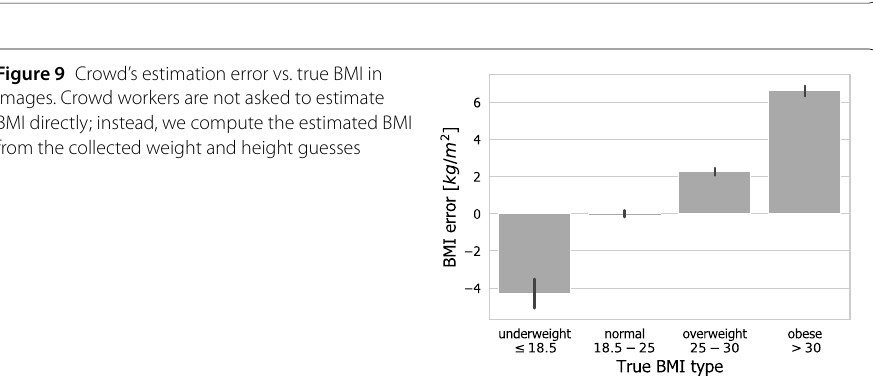
Figure 8 Dependence of the crowd’s estimation errors on the true weight/height of the images. The x -axes appear quantized because the ground-truth data consists of integer numbers (pounds for weight, inches for height)